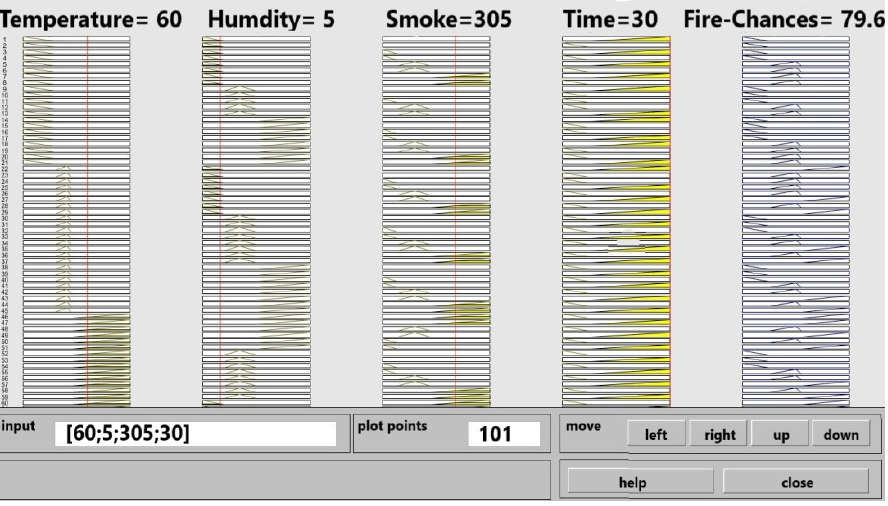
Figure 25. Experiment 3 Fire Chances in MATLAB Rules Viewer.